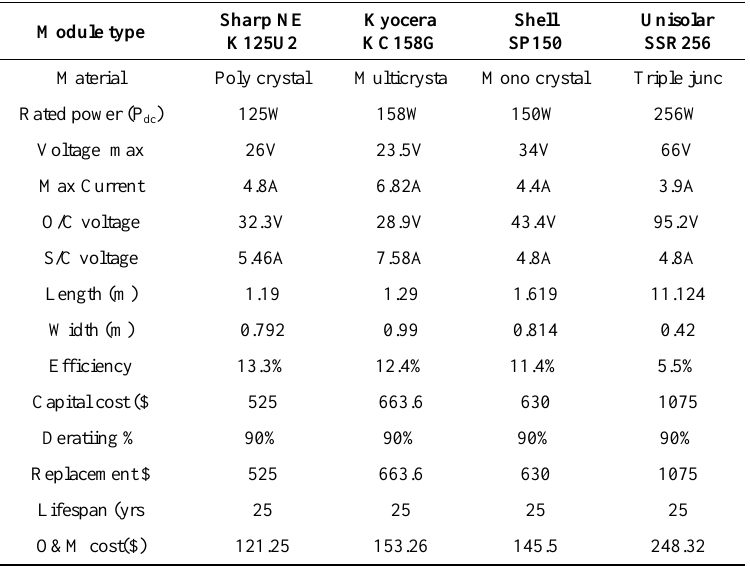
Table 2. Types of Solar PV and their Characteristics